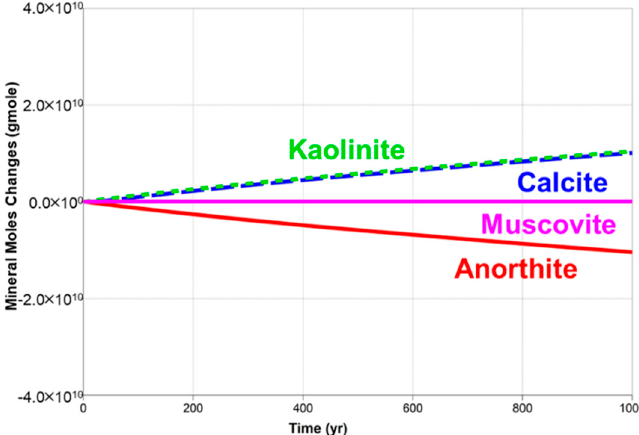
Figure 9. Evolutions of kaolinite, calcite, muscovite, and anorthite in the supercritical CO 2 scenario.